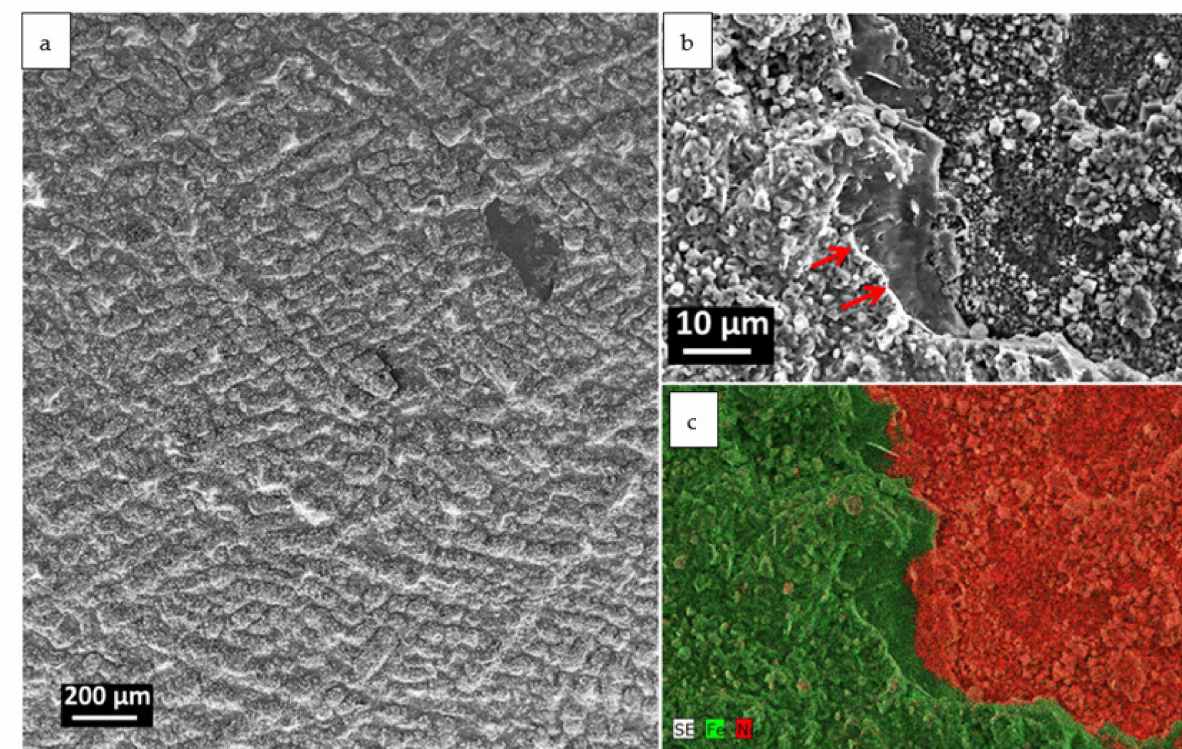
Figure 2. Surface of sample oxidized at 700 ◦ C for 500 h in steam: ( a ) overview, secondary electron image (SEM-SE), ( b ) area damaged by spallation (SEM-SE), ( c ) elemental map of Fe and